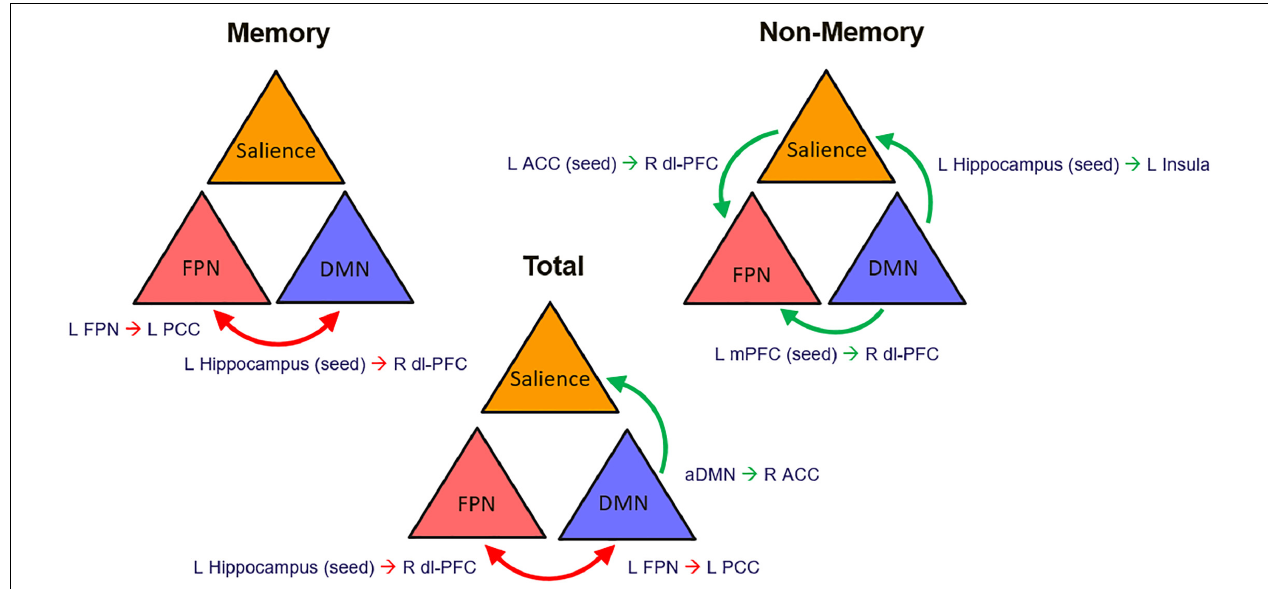
FIGURE 7 | Graphical representation of the proposed network dynamic changes that define multi-domain anosognosia in the early stages of AD. ACC, anterior cingulate cortex; aDMN, anterior Default Mode Network; dl-PFC, dorsolateral prefrontal cortex; FPN, Fronto-Parietal Network; mPFC, medial prefrontal cortex; red arrows, decreased connectivity; green arrows, increased